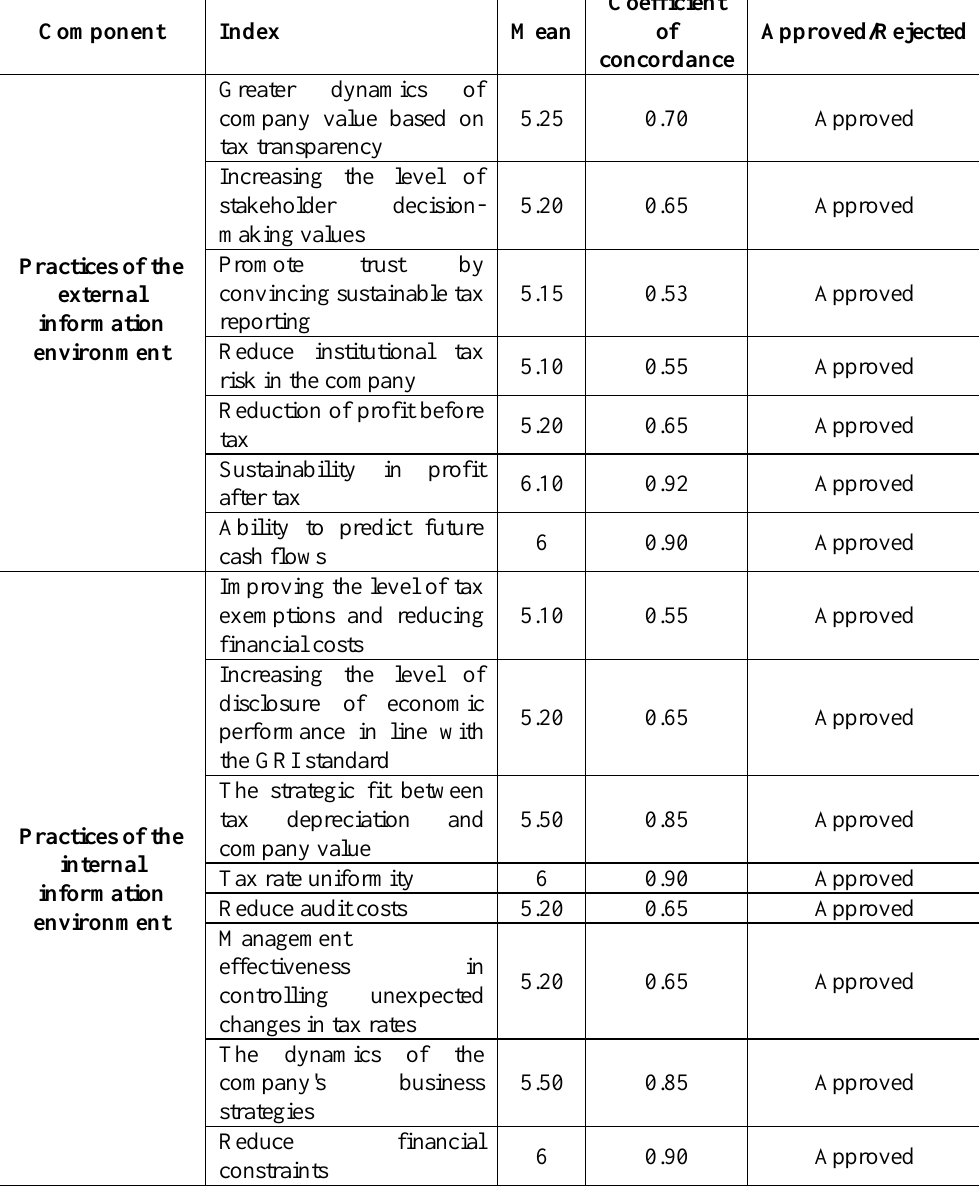
Table 7: Second-round Delphi analysis of the meta-synthesis results